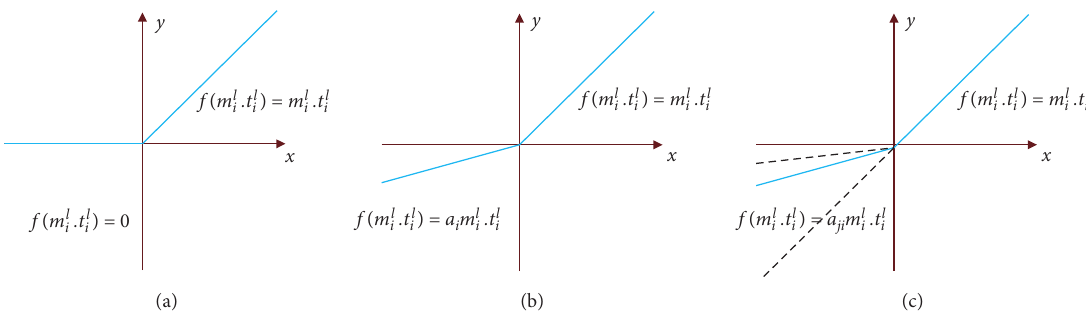
Figure 4: Mathematical models of (a) ReLU, (b) Leaky-ReLU/PReLU, and (c) RReLU